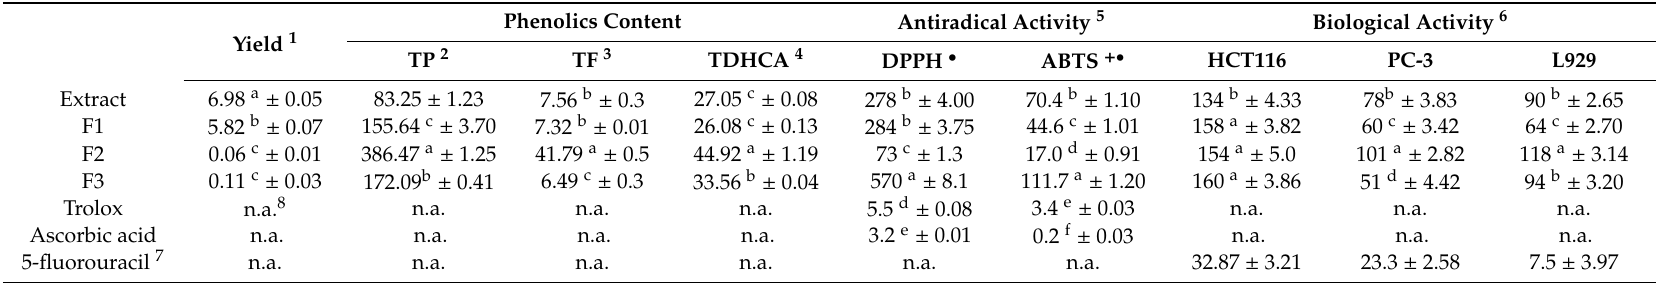
Table 1. Extraction yield, phenolic content, antioxidant, and biological activity of ethanolic extract (E) and water (F1), methanol-water 40% (F2), and 70% (F3) fractions obtained from sweet pepper fruit *